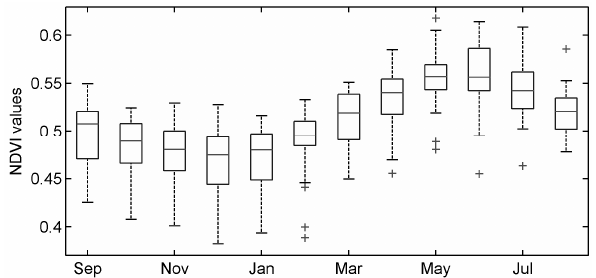
Figure 4. Annual cycle of monthly NDVI values for the standard hydrological year spanning from September of year n-1 to August of year n (with n from 1982 to 2006). The bottom/top indicates the lower/upper quartiles, and the band near the middle of the box is the median. The lower/upper end of the whiskers represents the lowest/highest observed value still within 1.5 of the interquartile range of the lower/upper quartile.